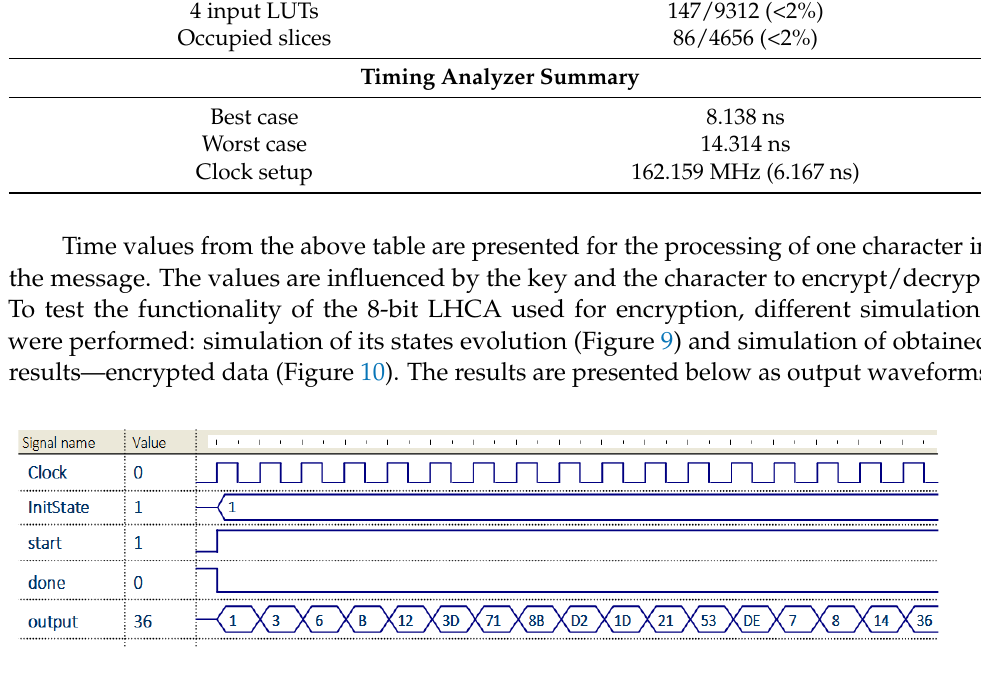
( b ) Figure 8. Interface with FPGA board: ( a ) Encryption process; ( b ) Decryption process.